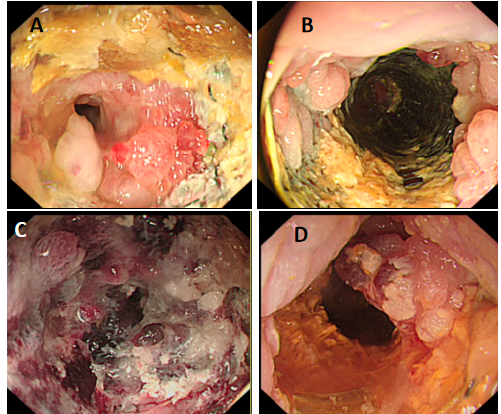
Figure 4. A patient with AGC receiving PDT. ( A ) Before treatment, atresia of the cardia can be seen; ( B ) it can be seen that the lumen is unobstructed after stent placement combined with PDT; ( C ) after one week of treatment, much gray-white necrotic tissue can be seen; ( D ) after three months of treatment, necrotic tissue can be seen to fall off, the lumen is unobstructed.